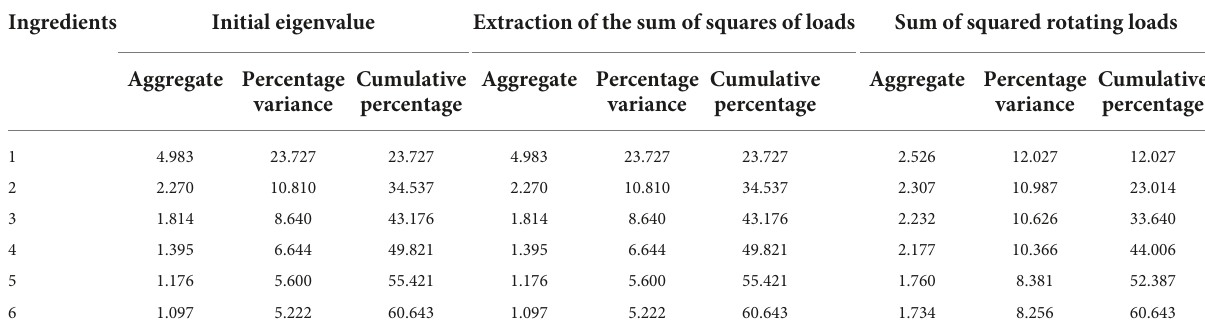
TABLE 2 Total variance explained with cumulative percentage of